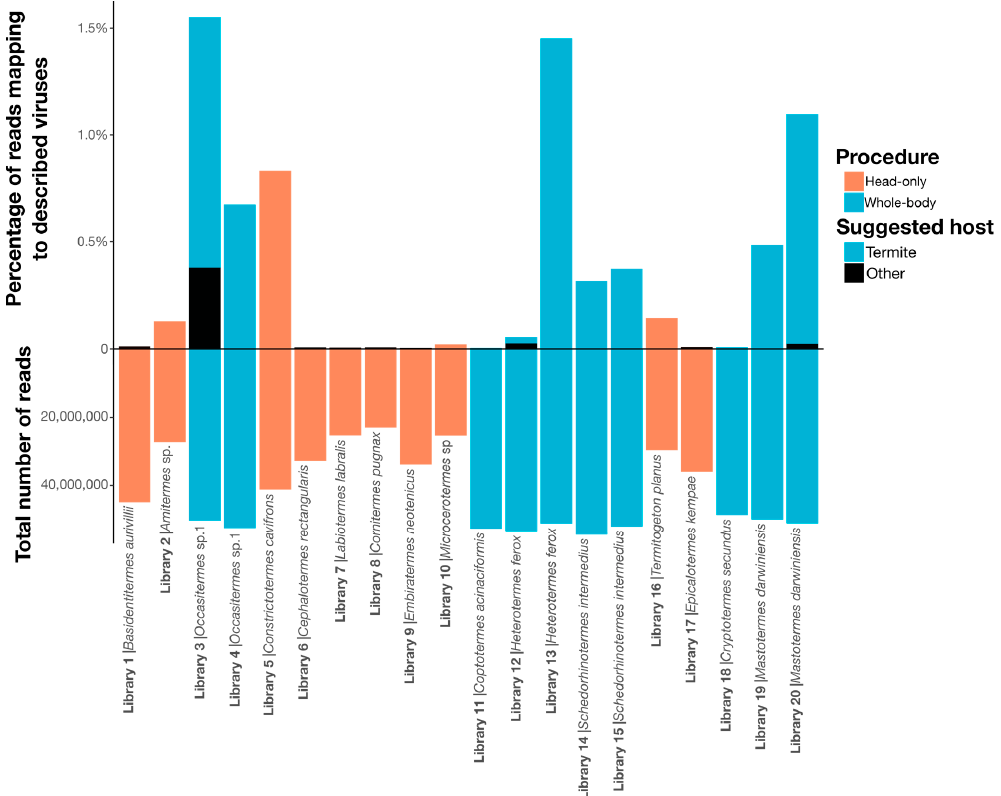
Figure 1. Bar graph depicting the number of reads in each sequencing library, below the x-axis, and the percentage of these reads that map to viruses described in this study, above the x-axis. Each library is labeled by name and termite species sampled. Bars are colored by sampling procedure. Sequenced contigs were annotated using BLAST (BLASTx and BLASTn) and conserved domain-based searches (CD-search) to identify putative viral contigs, excluding those matching commonly contaminating RNA viruses, endogenous viruses, retroviruses and any hits to DNA viruses (see Methods). Overall, an average of 68% of contigs per sample was unidentified (no significant BLAST hit), and 27.4% hit host sequences (i.e., from the phylum Arthropoda), 1.3% hit bacterial sequences and 0.024% of all contigs had a significant hit to a virus genome. After predicting open reading frames (ORFs) for contigs determined to represent true virus genomes, CD-search hits were used for annotation, and the predicted replicase genes were incorporated into phylogenetic trees to determine their